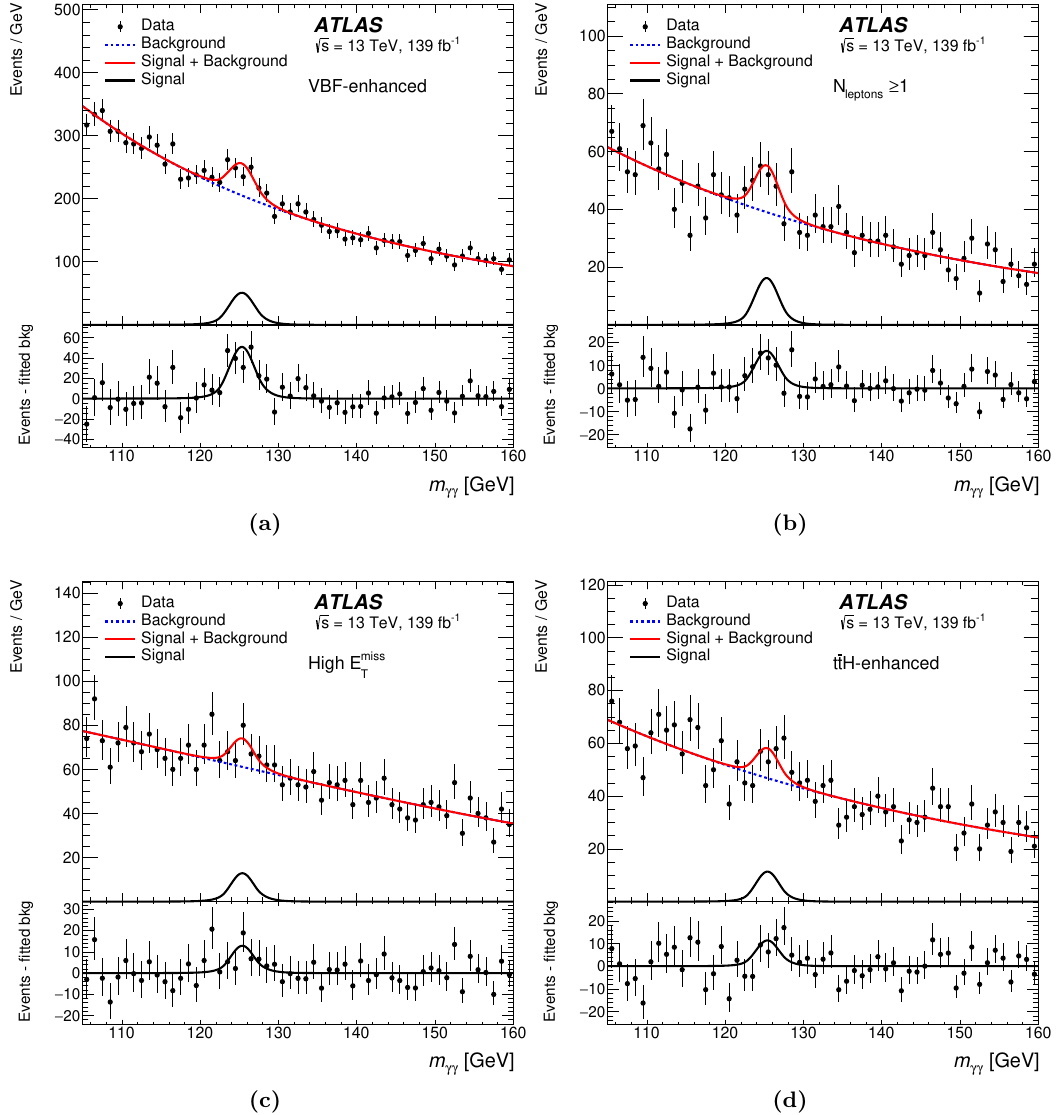
Figure 5. The diphoton invariant mass spectrum of events passing the selection for the region (a) VBF-enhanced, (b) N 1 , (c) High E miss and (d) t ¯ tH -enhanced. The solid red curve shows the lepton ≥ T fitted signal-plus-background model with the Higgs boson mass constrained to 125.09 ± 0.24 GeV. The bottom pad shows the residuals between the data and the background component of the fitted